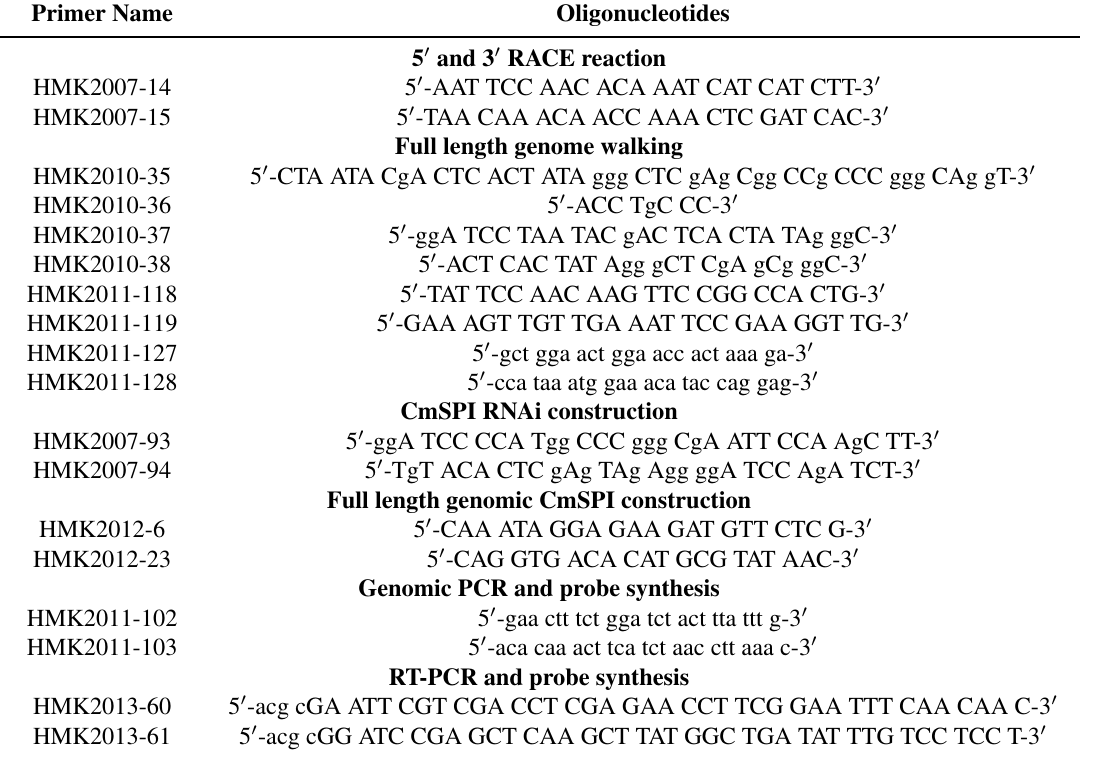
Table 1. Specific primers used in this